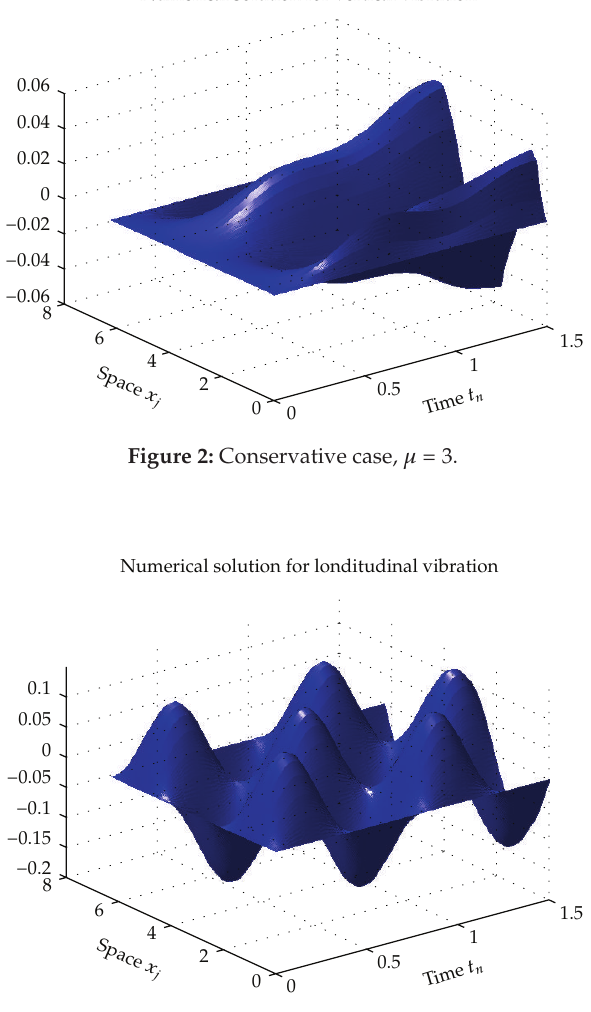
Figure 3: Conservative case, μ (cid:8)